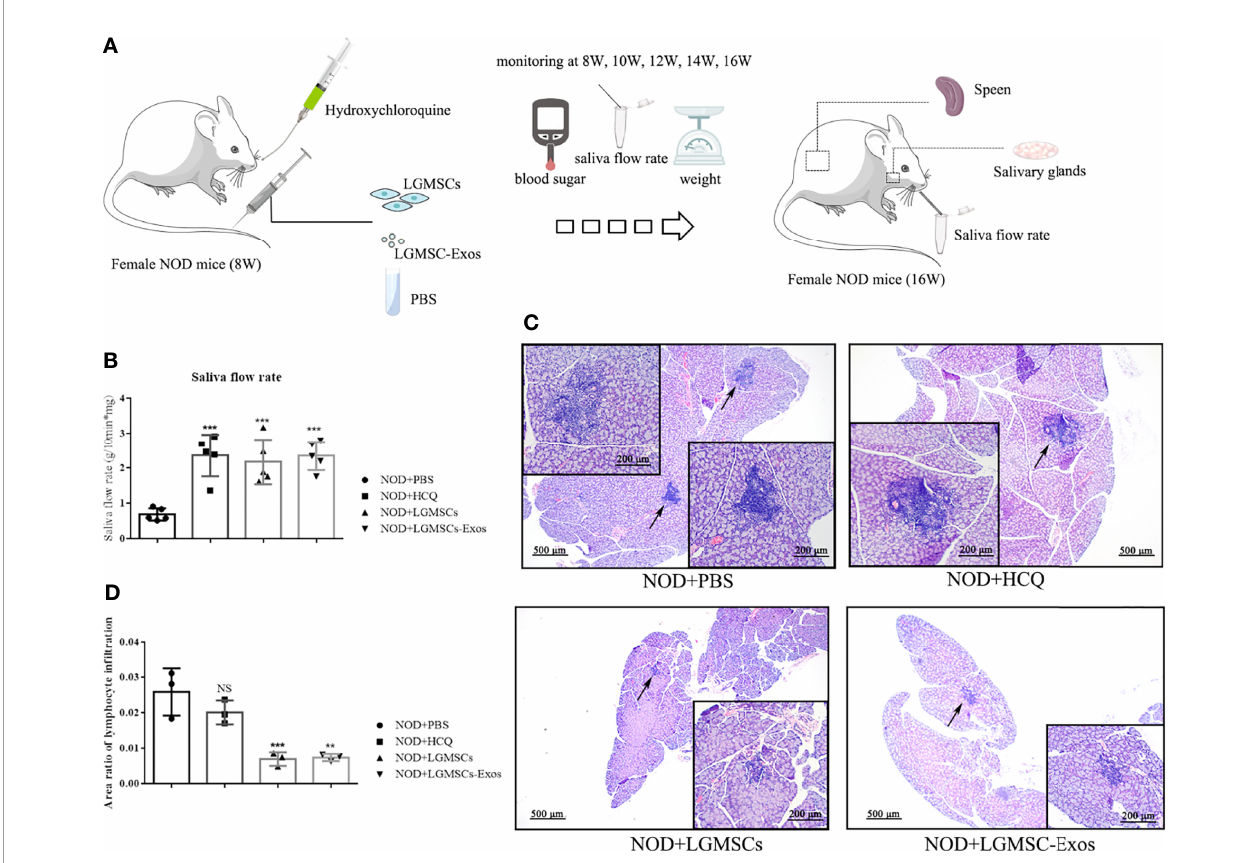
FIGURE 2 | Transfer of LGMSC-Exos alleviates disease progression of NOD mice. (A) Schematic diagram of mice treatments; (B) Mouse saliva fl ow rate in the various groups. Data represent the mean ± standard deviation (SD; n = 3 independent experiments). ***p < 0.001, compared with the PBS group; (C) Representative histological images in the salivary gland sections of the various groups of stained using H&E (magni fi cation: 100 × and 200 ×); (D) Area ratios of lymphocytic in fi ltration in the various groups. Data represent the mean ± standard deviation (SD; n = 3 independent experiments). NS, not signi fi cant, ***p < 0.001, **p < 0.01, compared with the PBS